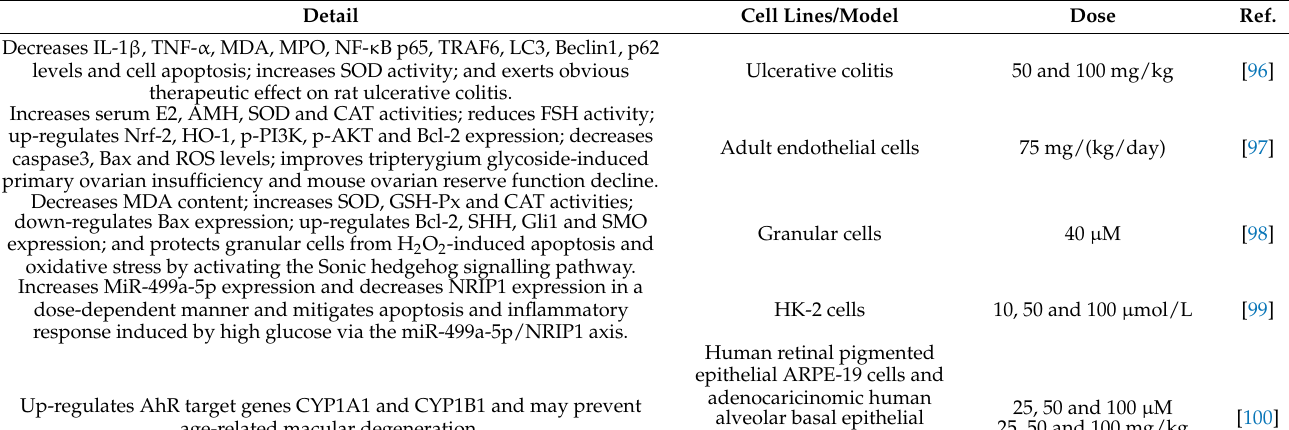
Table 11. Other Effects of